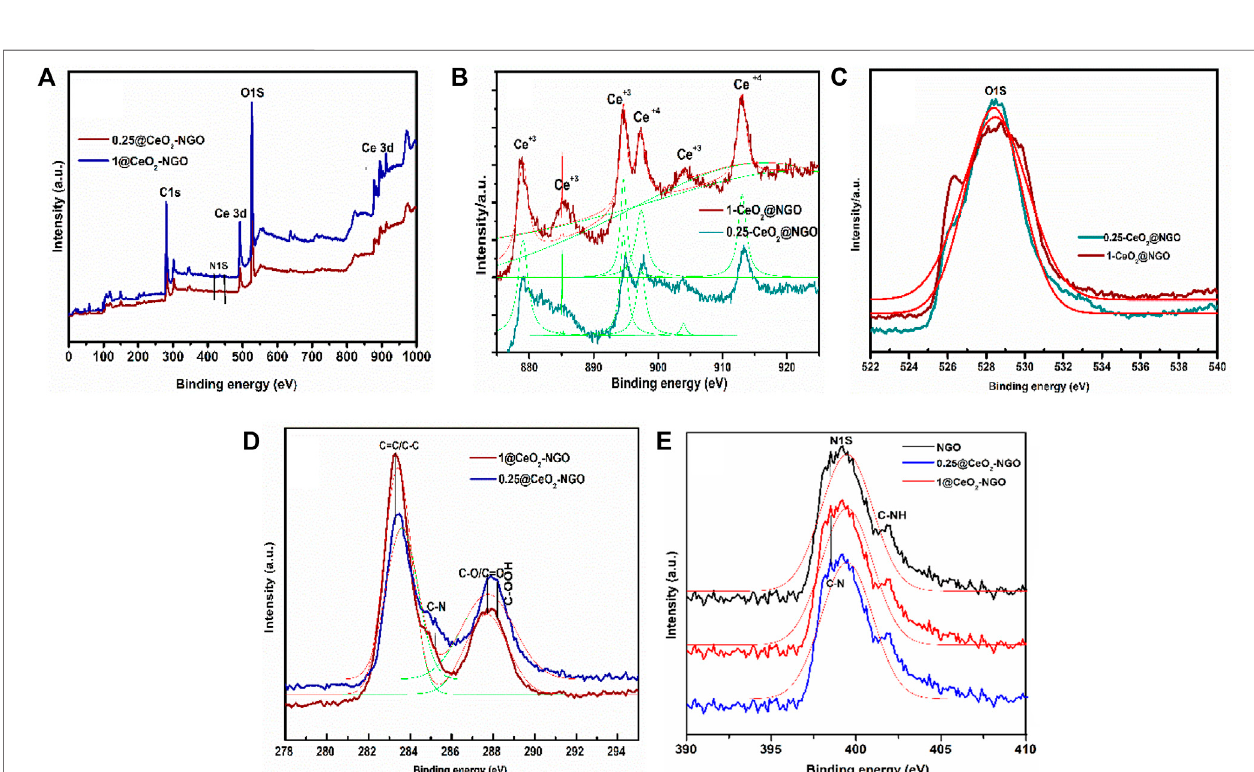
FIGURE 3 | (A) XPS survey scan of 0.25-CeO 2 @NGO and 1-CeO 2 @NGO. (B – E) High-resolution detailed scan of Ce 3d, O1S, C1S, and N 1S, respectively, for